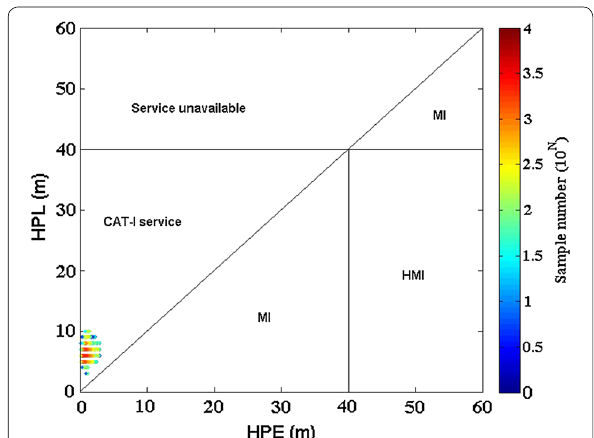
Fig. 5 Horizontal performance of SXTY station